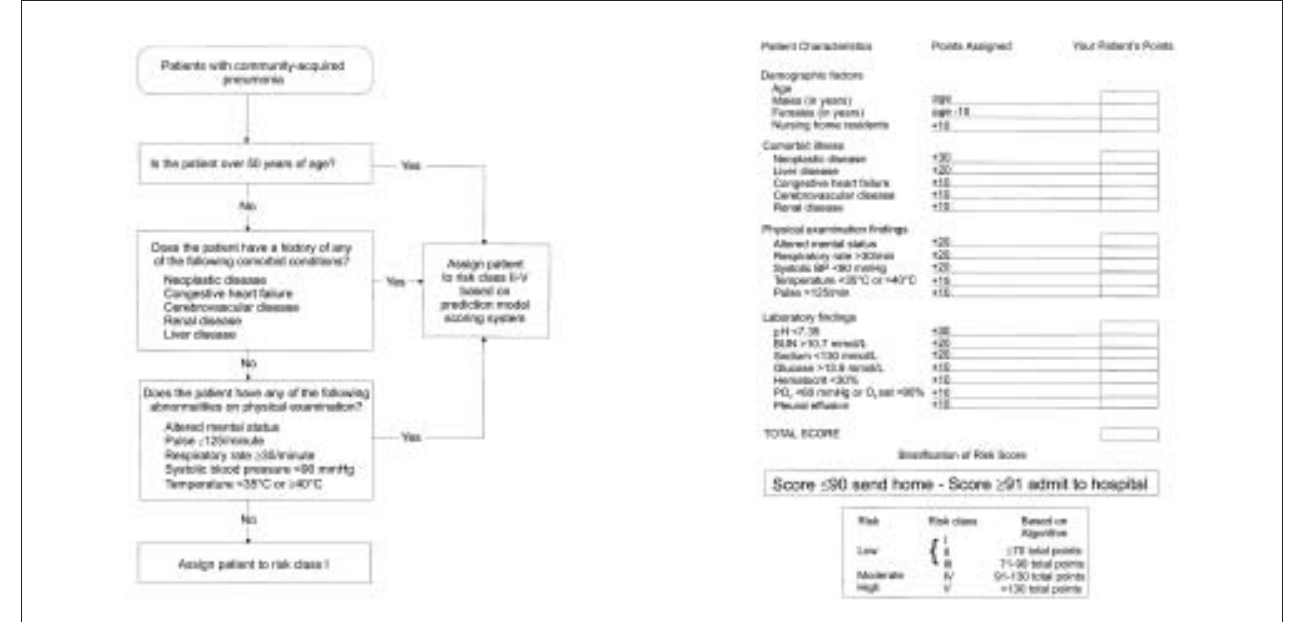
Figure 2) Prediction model for identification of patient risk for persons with community-acquired pneumonia (left) . Pneumonia-specific severity of illness scoring system (right) . Reproduced with permission from reference 49. BP Blood pressure; BUN Blood urea nitrogen; O 2 Oxygen; PO 2 Partial pressure of